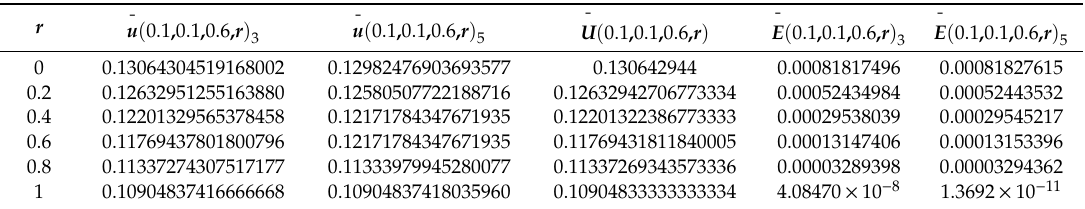
Table 4. Solution and accuracy of third and fifth order double parametric fuzzy HPM solutions for Equation (24) at t , x = 0.1 and b = 0.6 for all r ∈ [ 0,1 ] .